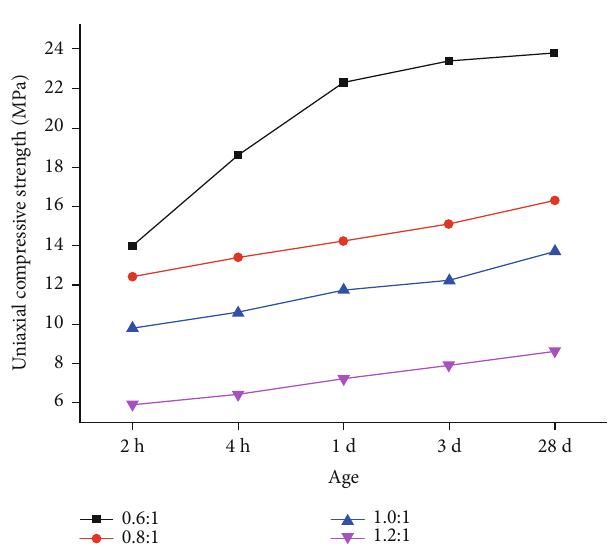
Figure 8: Slurry performance (water-cement ratio 0.6:1).